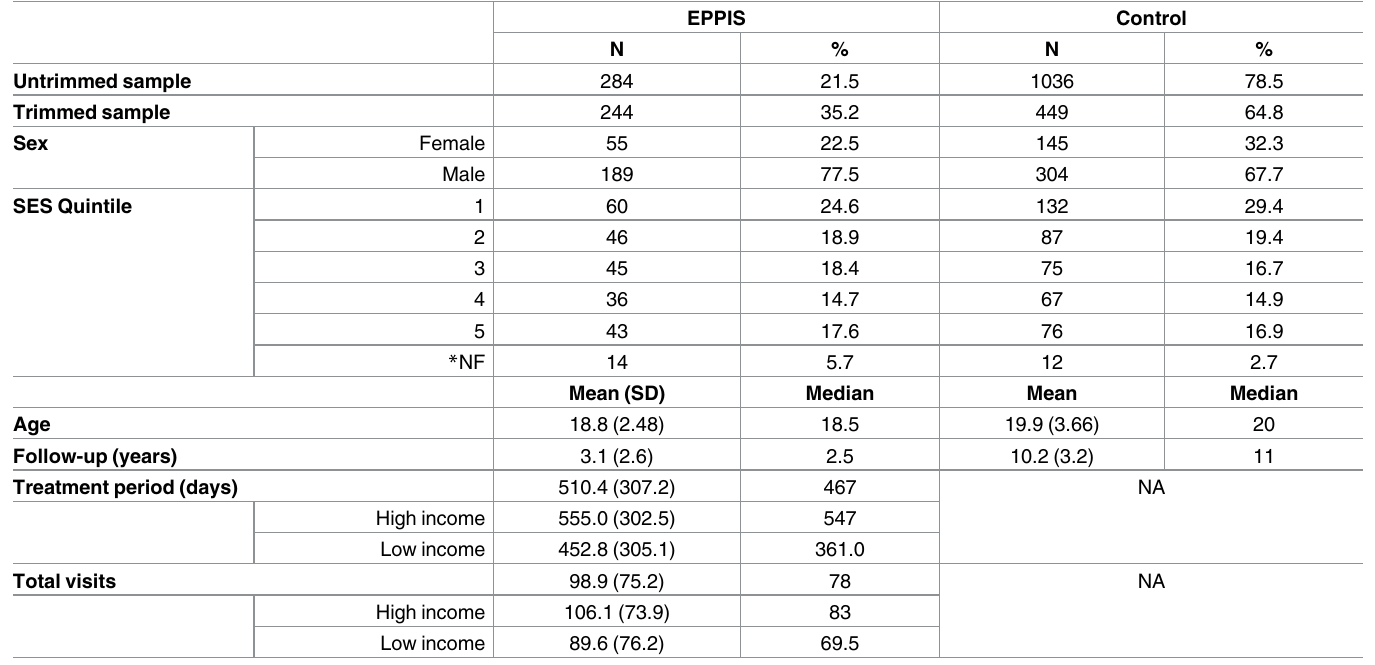
Table 2. EPPIS and control group demographics and treatment statistics.